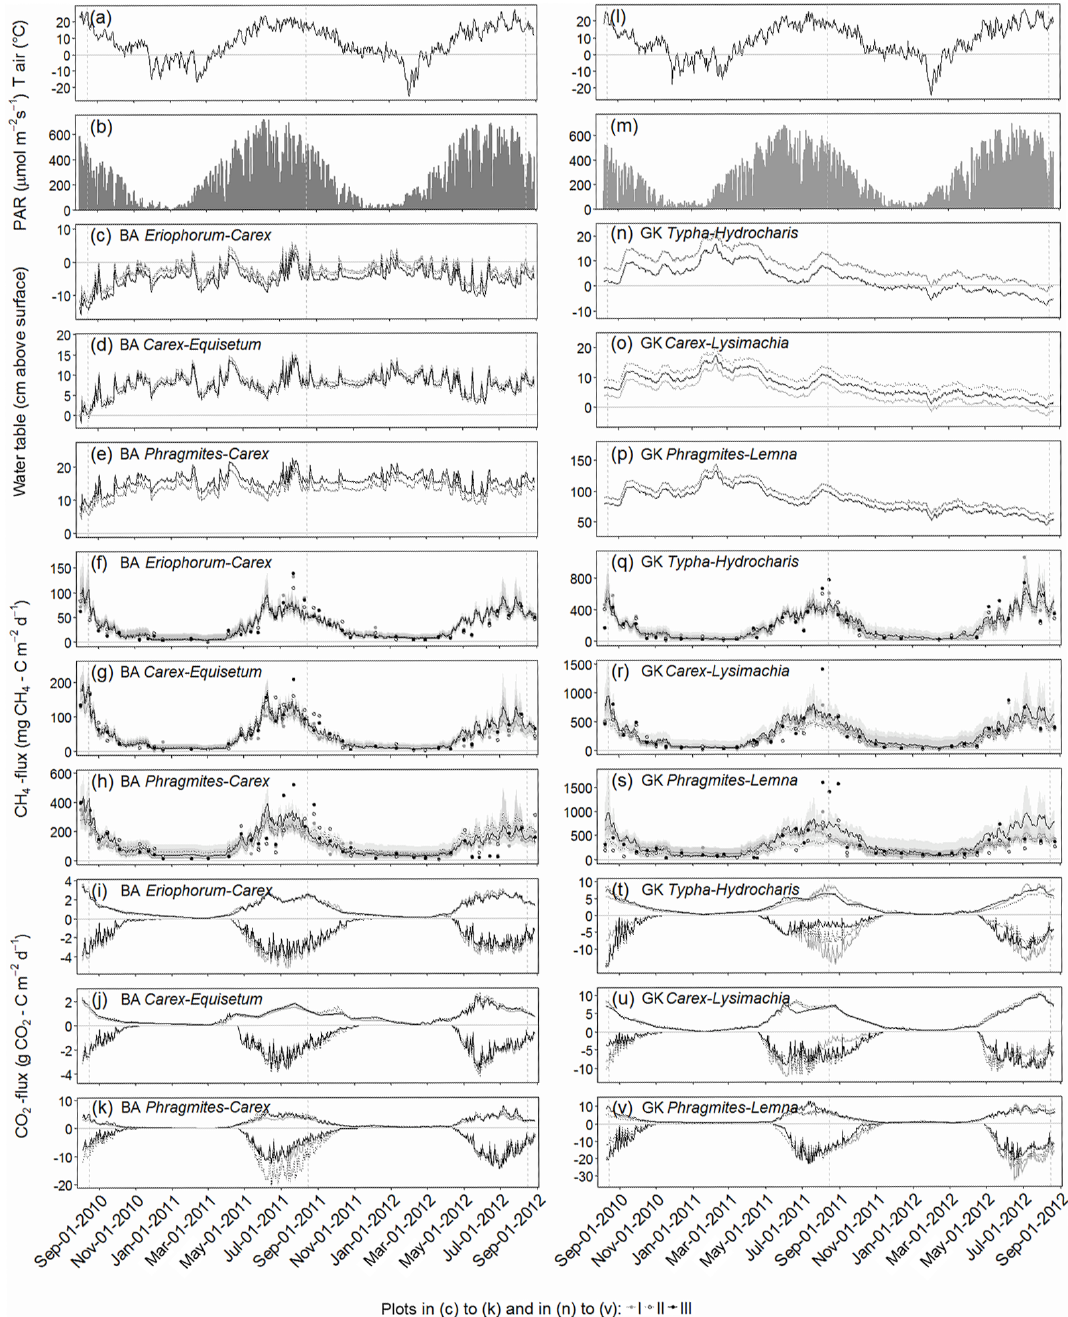
Figure 4. Mean daily air temperature (a) and mean daily PAR (b) at Višnieva (a, b) and Z’dzitava (l, m) , mean daily water table posi- tions, mean daily measured (points) and modelled (lines) CH 4 fluxes, and mean daily modelled (H approach) GPP, and R eco (i, j, k) of Barcianicha (c–k) and Giel’ ˇ cyka ˘ u Kašyl’ sites (n–v) .